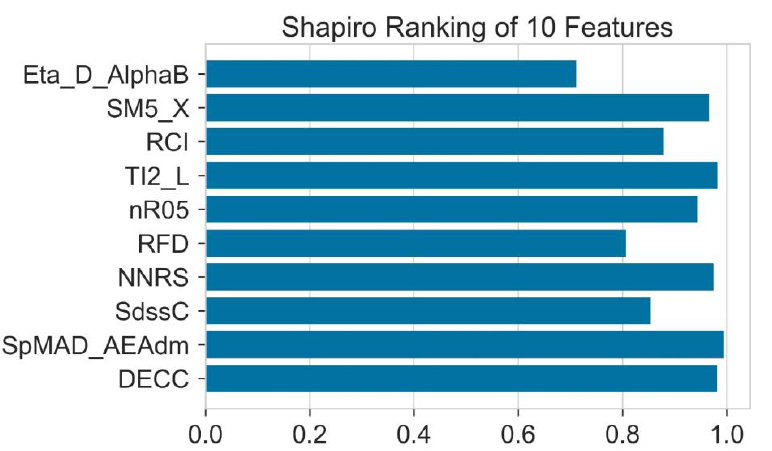
Figure 3. The normality of all the features analyzed by Shapiro test.